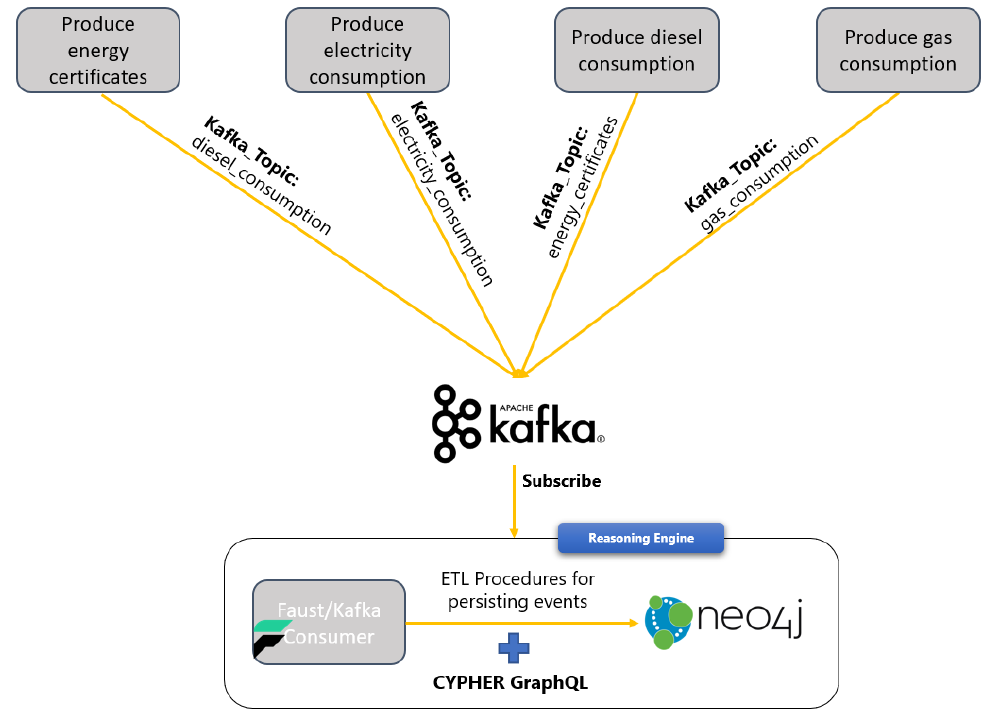
Figure 3. Data flow in the Reasoning Engine Kafka consumer.